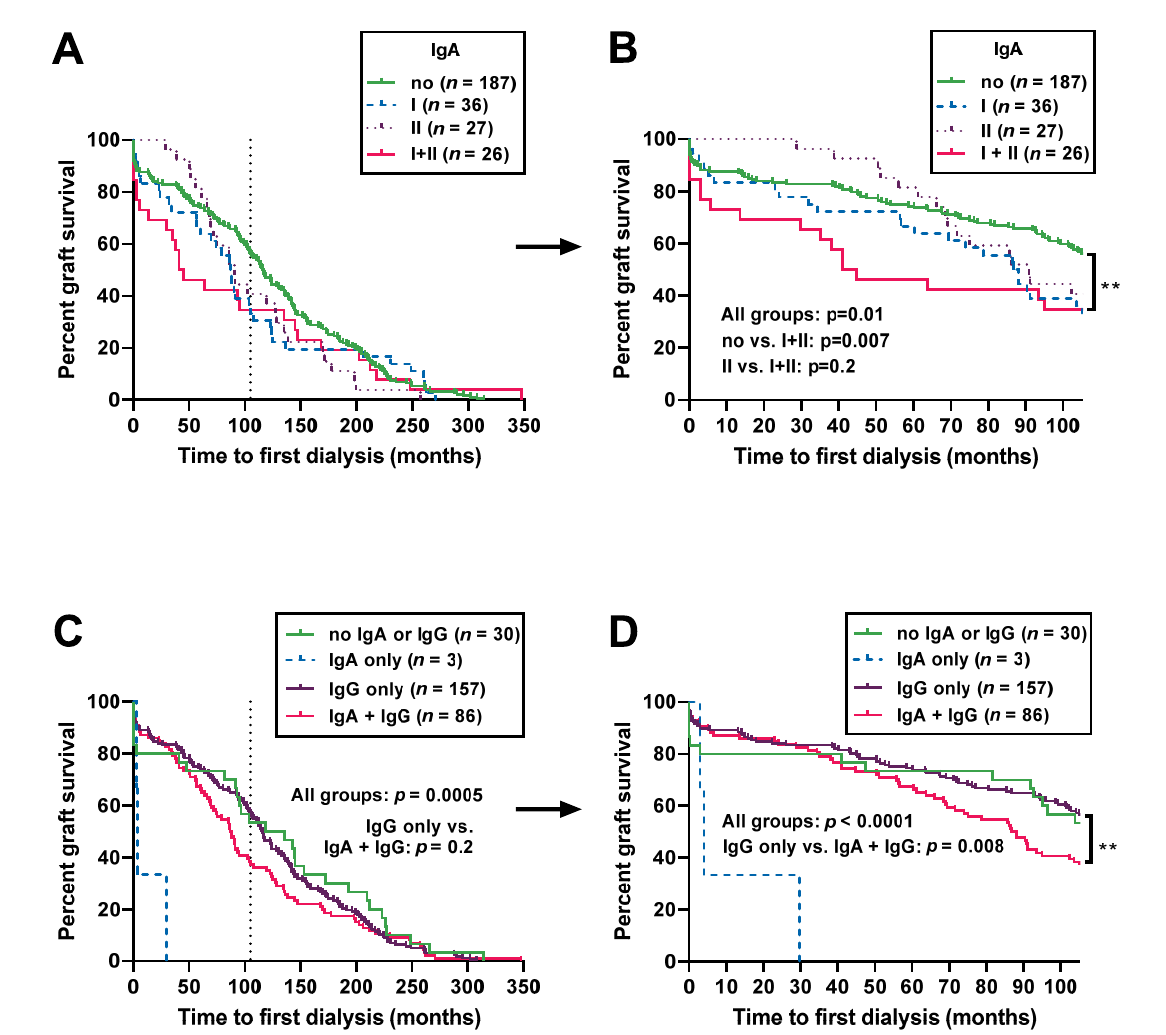
Figure 2. Impact of anti-HLA IgA and IgG antibodies on kidney allograft survival. This analysis includes 276 patients with allograft failure. Panel ( A , B ) shows allograft survival stratified by the presence of IgA antibodies against HLA class I (I), HLA class II (II) or both (I+II). Panel ( B ) shows only the earlier course of IgA antibodies (<median time of 105 months), which was analyzed after censoring the data. Panel ( C , D ) shows allograft survival stratified by the presence of IgA and/or IgG antibodies against any HLA-antigen. Panel ( D ) shows the earlier course of IgA and/or IgG antibodies (< median time of 105 months). The time to first dialysis was used as a measure of the duration of allograft function. Graft survival of various groups was compared by Log Rank (Mantel–Cox) test. ** p < 0.01.